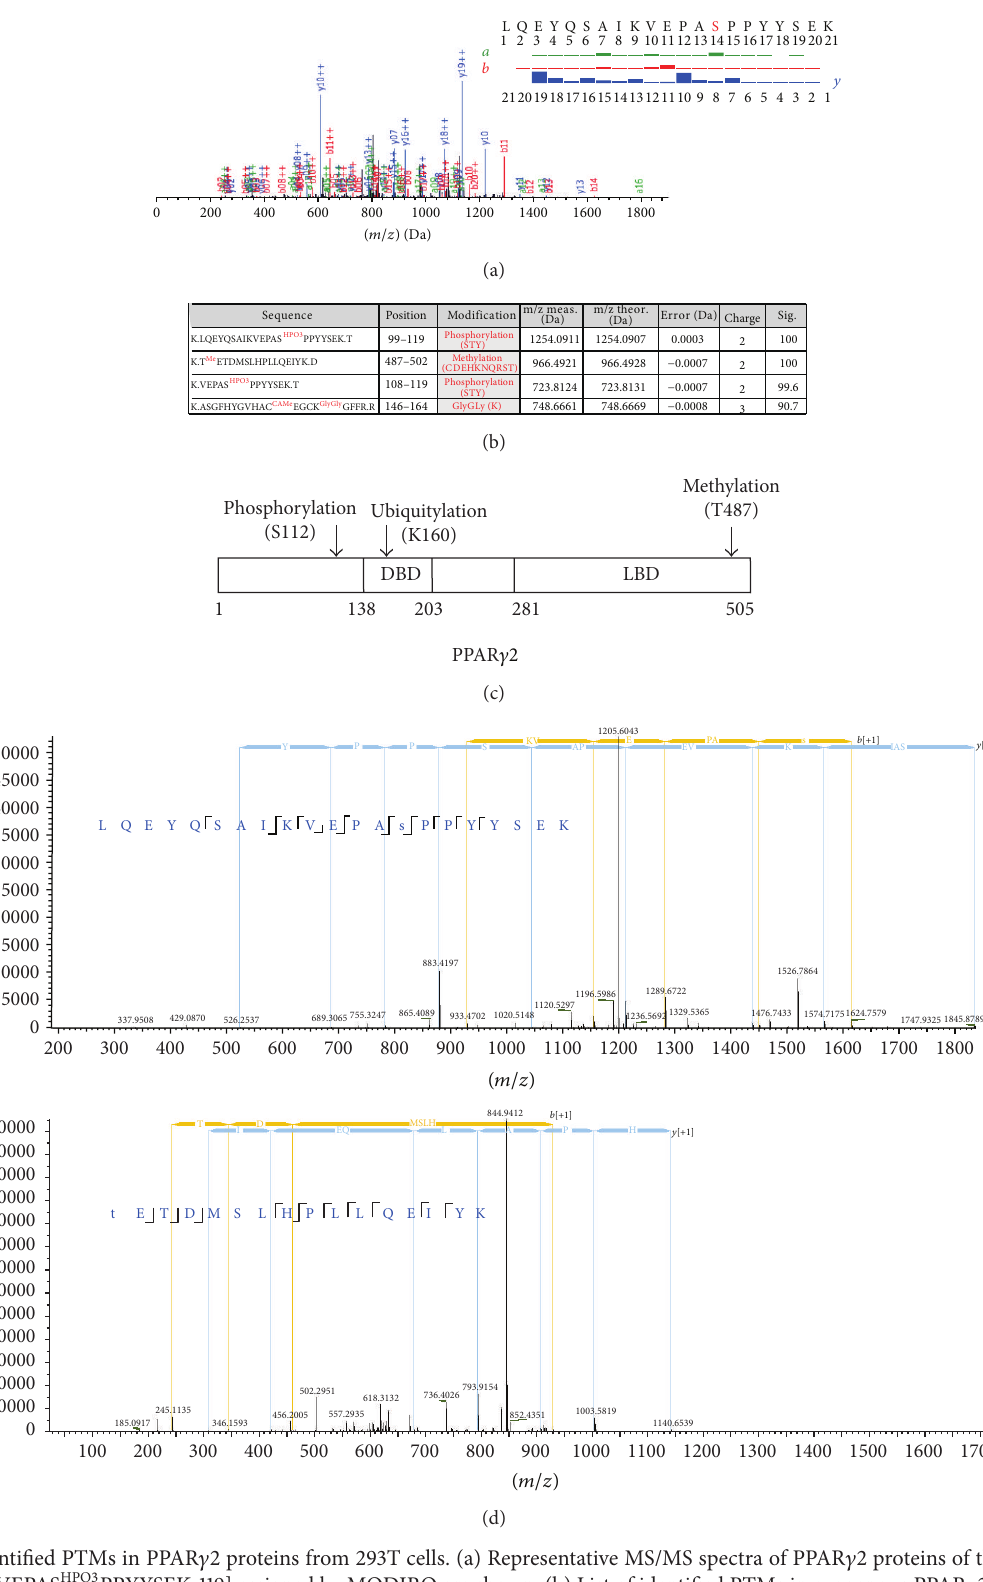
Figure 3: Identified PTMs in PPAR 𝛾 2 proteins from 293T cells. (a) Representative MS/MS spectra of PPAR 𝛾 2 proteins of the peptide [99- LQEYQSAIKVEPAS HPO 3 PPYYSEK-119] assigned by MODIRO are shown. (b) List of identified PTMs in exogenous PPAR 𝛾 2 proteins using ion trap MS/MS. Amino acid sequences, position of amino acids, identified PTMs theoretical mass, measured mass, error between measured and theoretical masses in Daltons, and significance score are listed. (c) Diagram for summary of identified PTMs in exogenous PPAR 𝛾 2 proteins. (d) Identified PTMs in exogenous PPAR 𝛾 2 proteins using FT MS/MS. Each responsible spectrum for S112 (top) and T487 (bottom) is